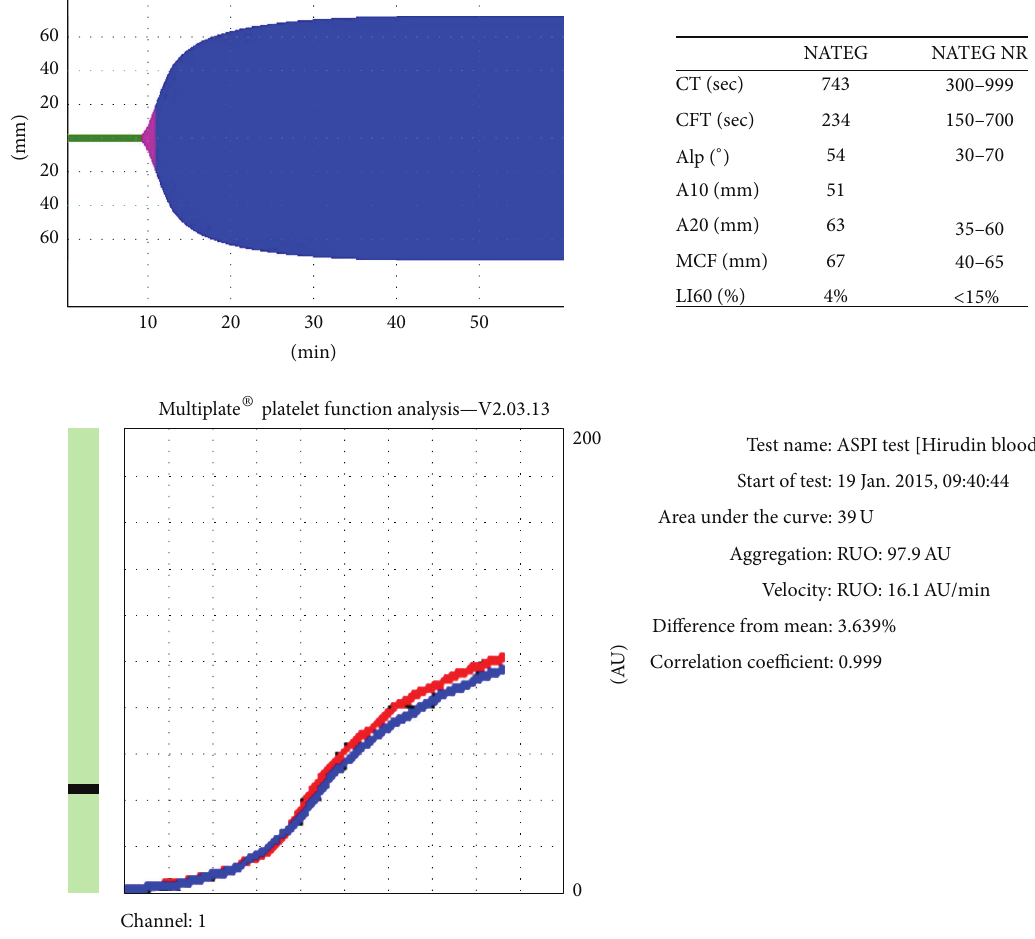
Figure 1: Rotational thromboelastometry: NATEM and multiplate ASPI performed on 22 weeks of gestation. ROTEM: clotting time (CT) for ROTEM is defined as the time in minutes it takes for the trace to reach an amplitude of 2 mm. Clot formation time (CFT) is defined as the time necessary for clot amplitude to increase from 2 to 20mm. Angle ( 𝛼 ) is determined by creating a tangent line from the point of clot initiation (CT) to the slope of the developing curve. Maximum clot firmness (MCF) is the peak amplitude (strength) of the clot. Lysis Index 30 (LI30) is the percent reduction in MCF that exists when amplitude is measured 30 min after CT is detected. Multiplate: results are expressed in AUC (area under the curve = area under the aggregation curve) units (U) and are recorded against time. The AUC reflects overall platelet activity, which is affected by the height of the aggregation curve. Agonists tested multiplate ASPI (arachidonic acid; final concentration, 0.5